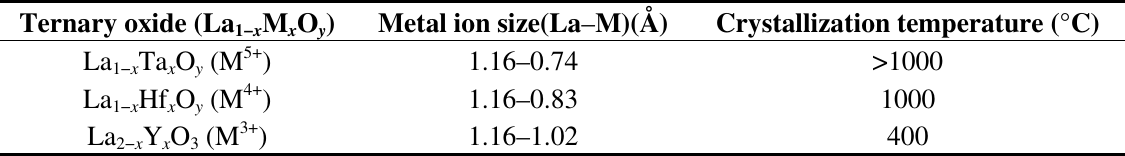
Table 2. Crystallization temperatures of La M 4+ and M 5+